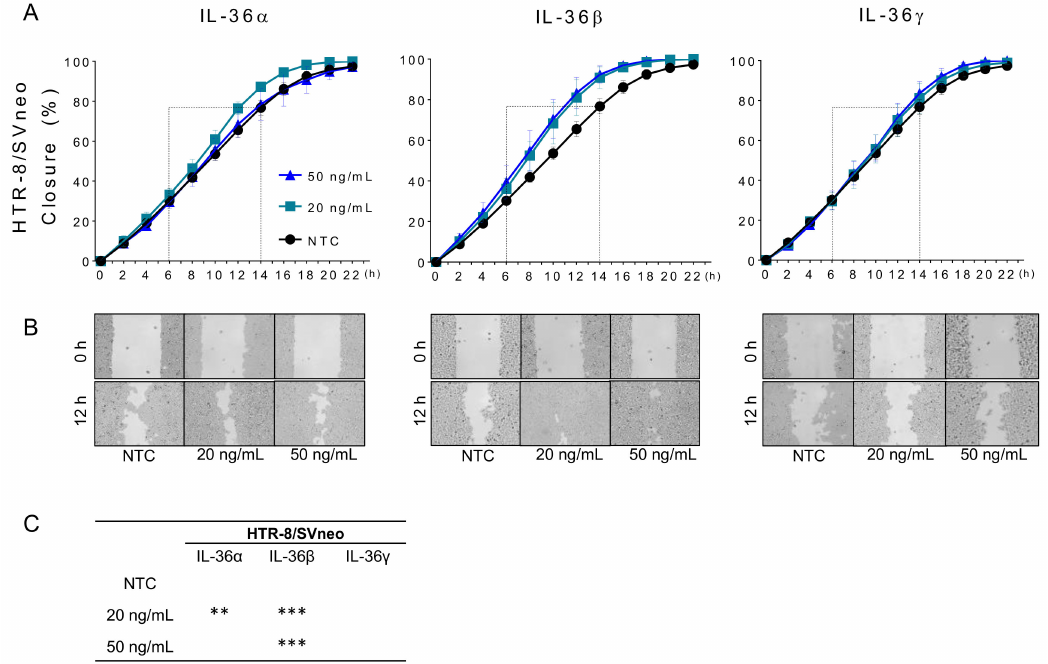
Figure 3. Effect of recombinant IL-36 ( α , β , and γ ) on trophoblast cell migration. ( A ) Closure rate curves for HTR-8/SVneo cells treated with different concentrations of IL-36 α , IL-36 β , or IL-36 γ . Dashed boxes denote the region-of-interest (ROI) selected for statistical analysis. ( B ) Representative images showing cell distribution at 0 and 12 h. ( C ) Statistical analysis of “wound healing” increase induced by IL-36 ( α , β , and γ ) compared to non-treated cells (NTC) in the ROI. Results from three independent experiments are shown as mean ± SEM. Two-way ANOVA with Tukey ´ s multiple comparison test. ** p < 0.01, *** p < 0.001 against NTC